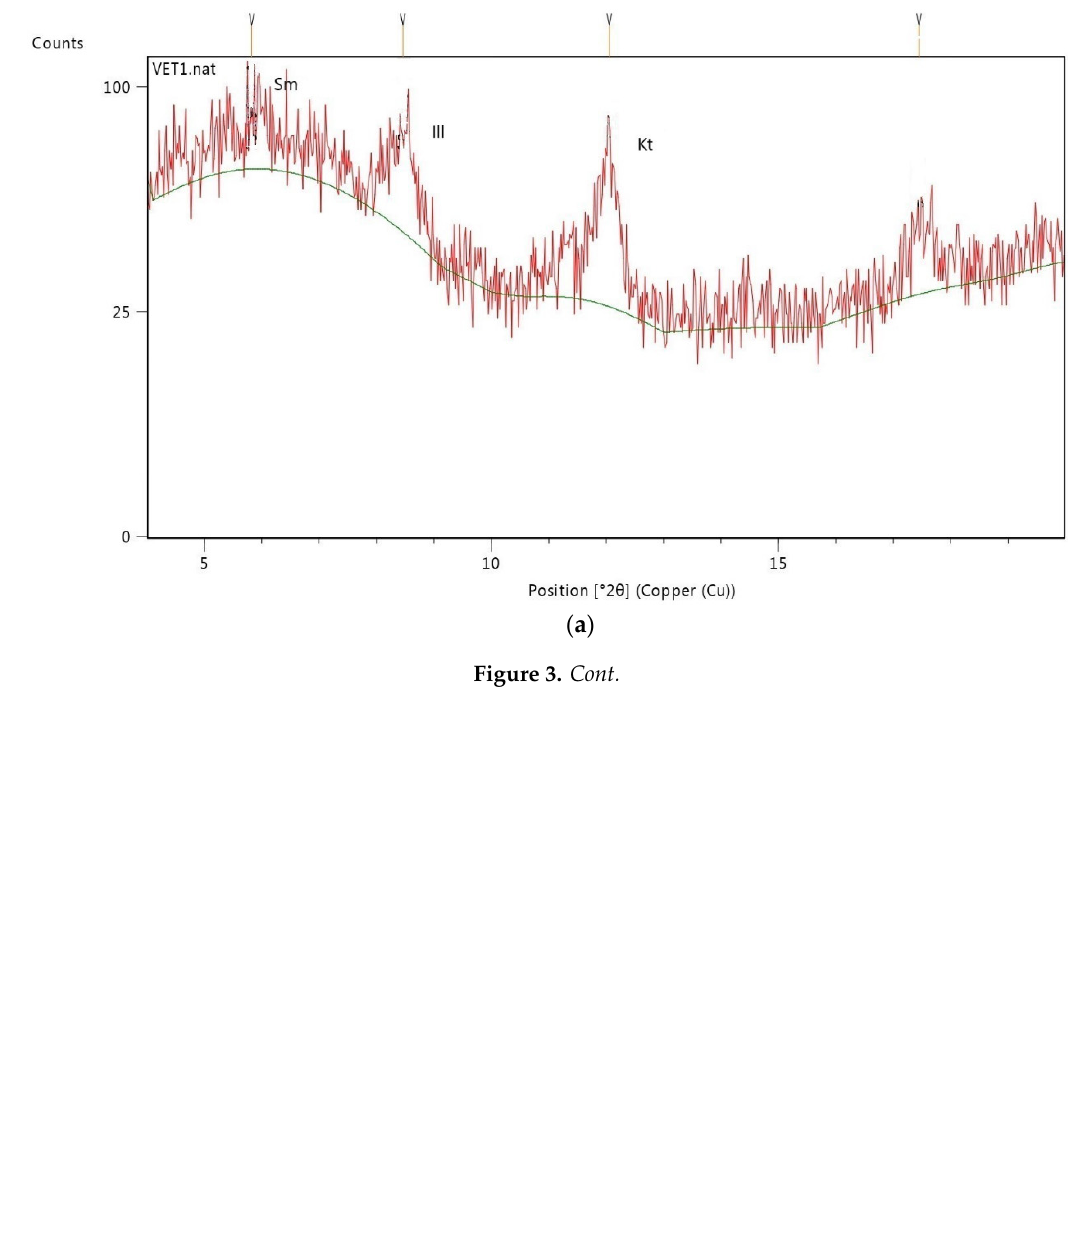
Figure 2. X-ray di ff raction (Cal: calcite; Qz: quartz; Dol: dolomite; Phy: phyllosilicates).